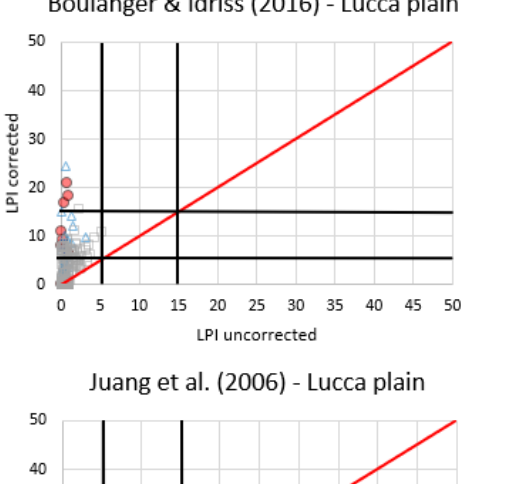
Figure 15. LPI (corrected) vs. LPI (w/o corrections) for the macro-area of Versilia.